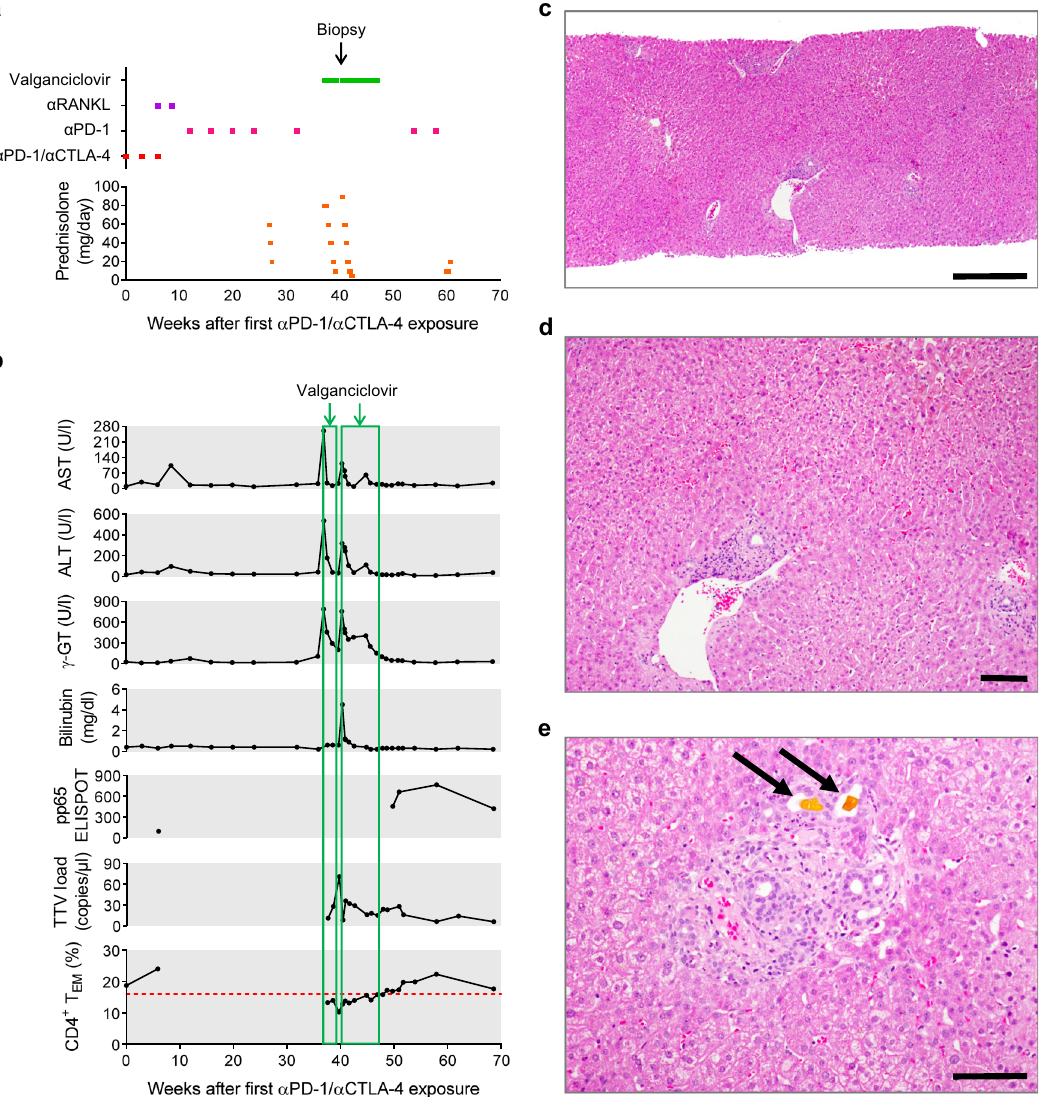
Fig. 7 Case 1: valganciclovir treatment of late-onset α PD-1/ α CTLA-4-related hepatitis. A 54-year-old male patient who received α PD-1 (Nivolumab) plus α CTLA-4 (Ipilimumab) dual therapy for metastatic melanoma presented with late-onset hepatitis. a Course of treatment. b Change in hepatitis-related parameters over time and their association with introduction, withdrawal and re-introduction of valganciclovir treatment. c The patient presented at the end of week 40 with recrudescent hepatitis and was treated with 900 mg/day valganciclovir for 2 days prior to liver biopsy. Histopathological image of the liver biopsy (H&E staining; scale bar 500 µ m). d Generally, the liver parenchyma appeared normal (H&E staining; scale bar 100 µ m). e Only a few lymphocytes and sparse necrotic hepatocytes were observed in portal areas with small bile plugs (arrows) with no signs of hepatitis (H&E staining; scale bar 100 µ